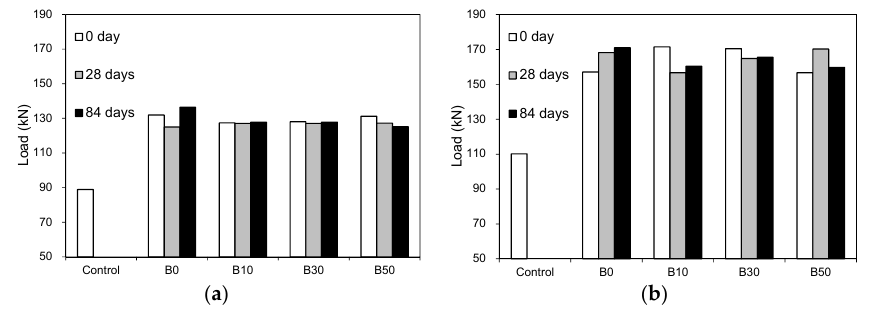
Figure 6. Residual load-carrying capacity of test beams: ( a ) yield load; ( b ) ultimate load.